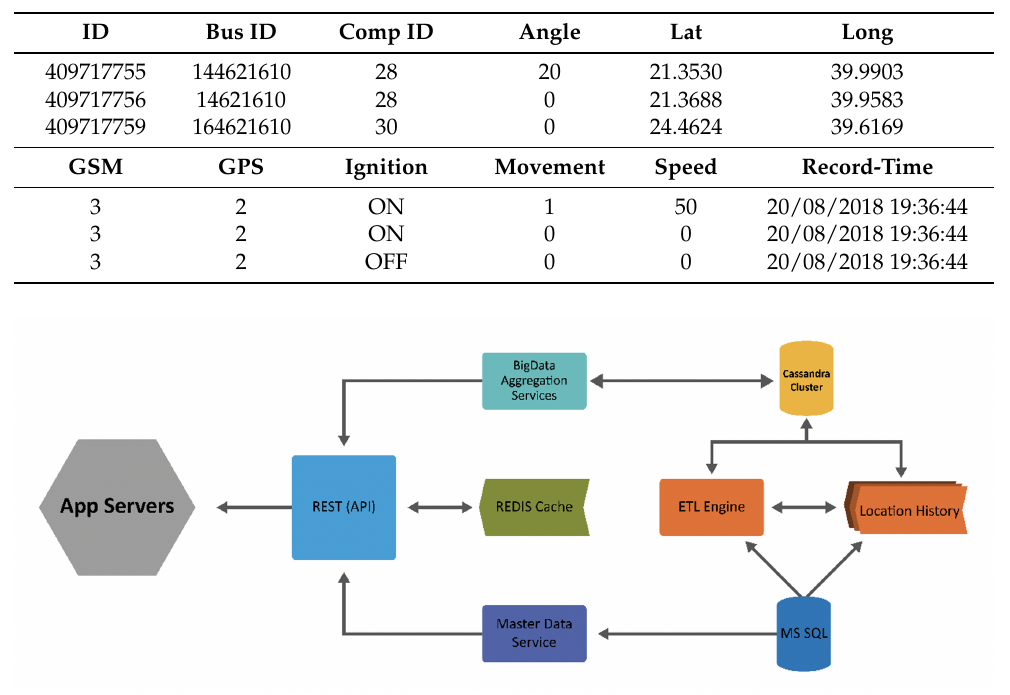
Figure 7. High-Level architecture of data